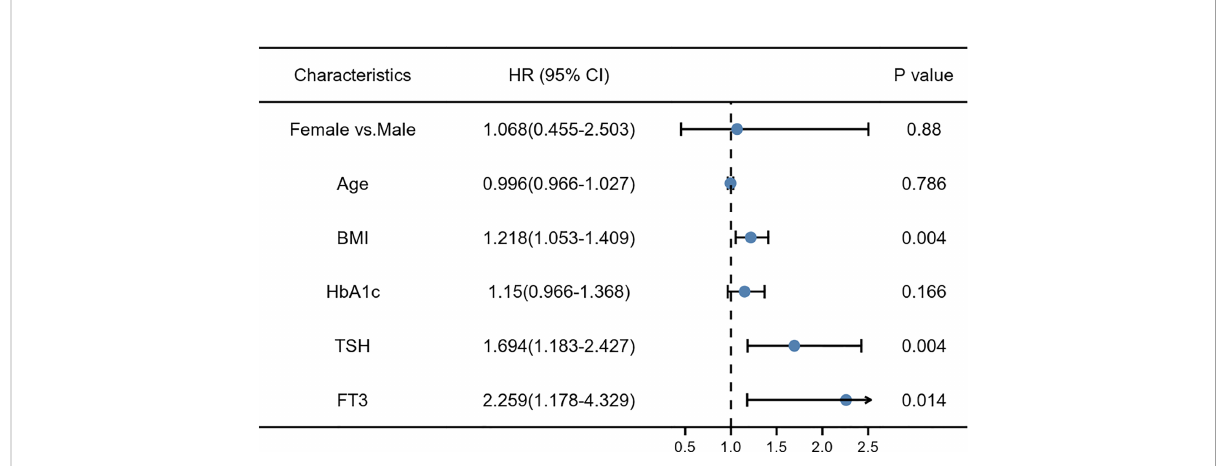
FIGURE 1 The multivariate logistic risk regression model: the risk factors for non-alcoholic fatty liver disease